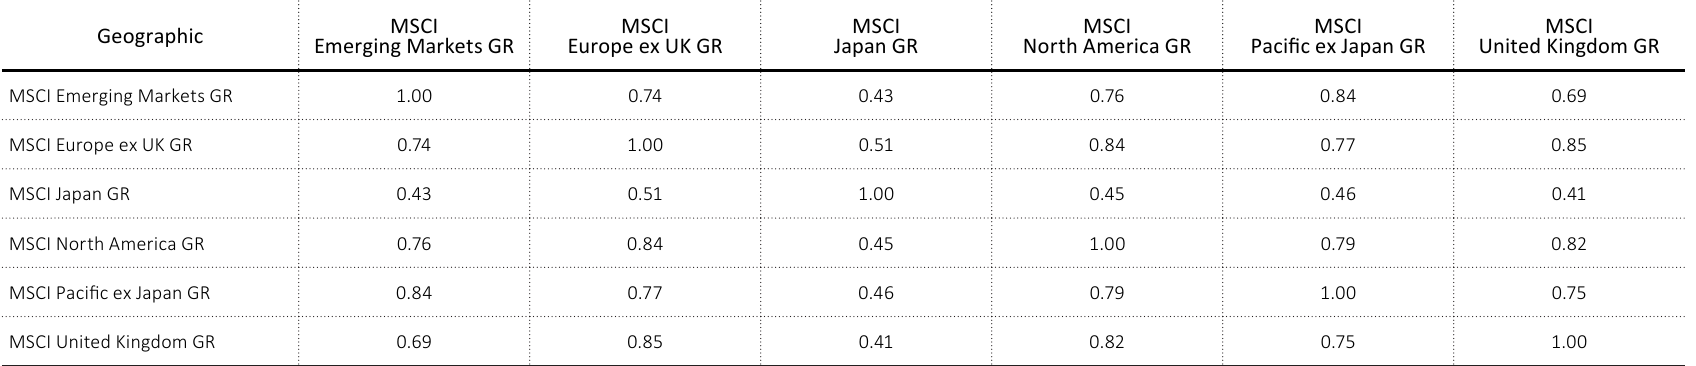
MSCI MSCI MSCI Japan GR Europe ex UK GR North America